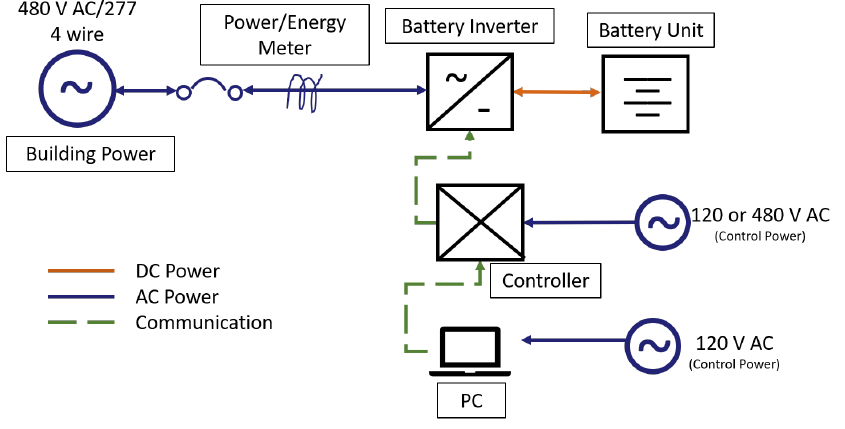
Figure 1. Hardware setup for grid-connected battery